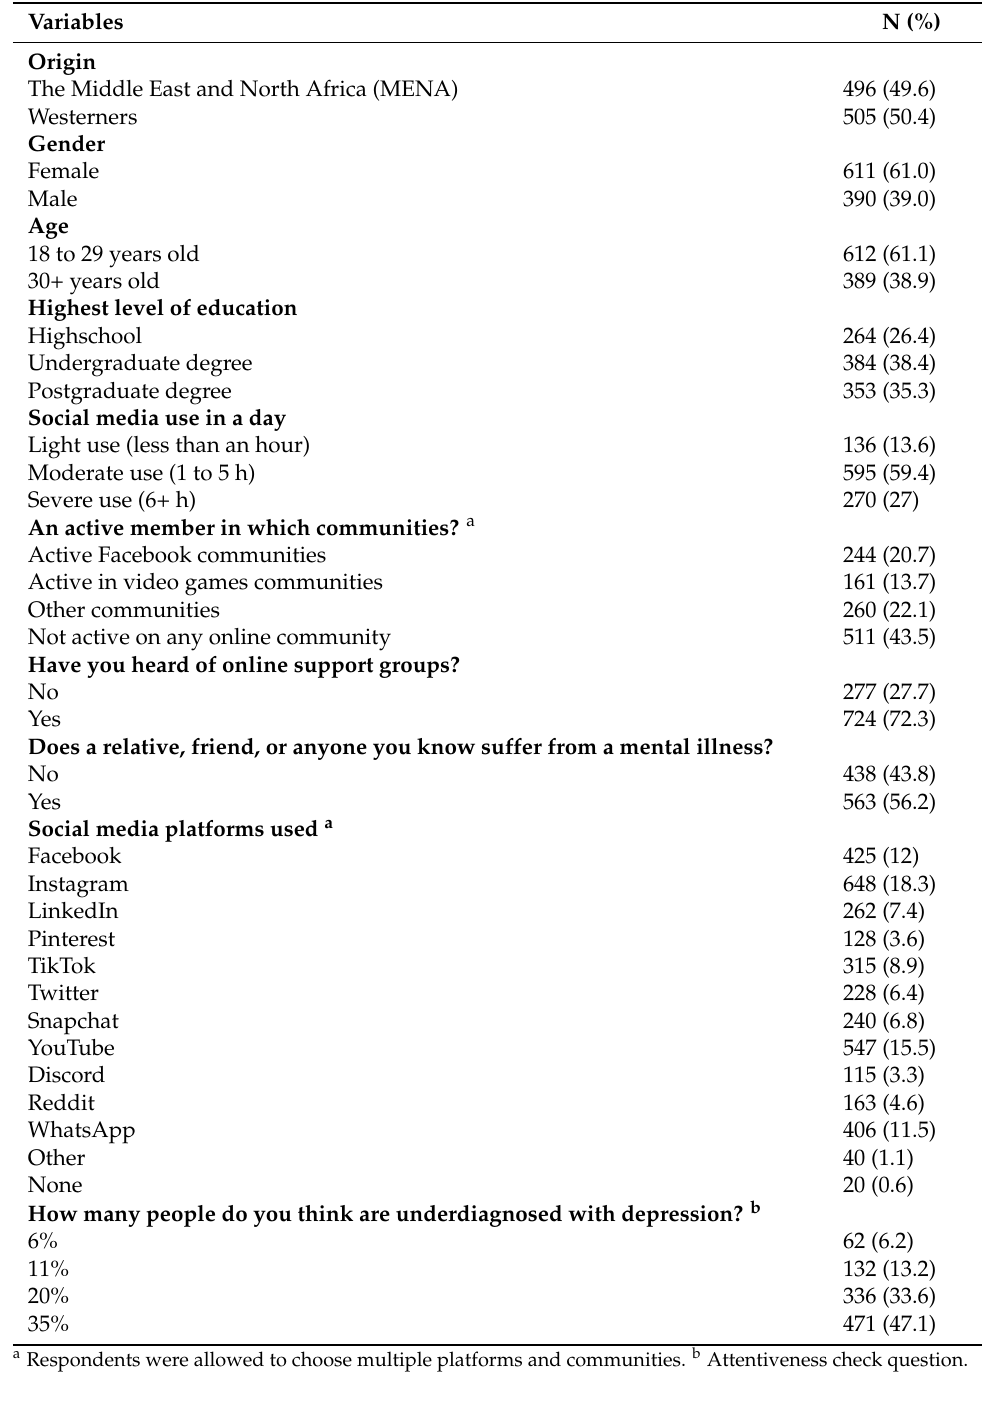
Table 1. Respondents’ demographics and other